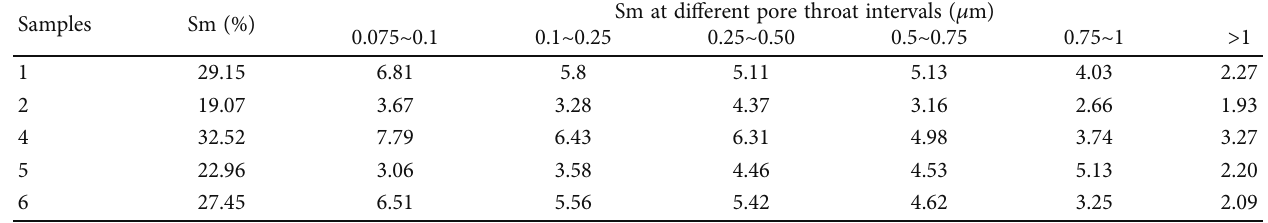
Figure 8: The variation of water saturation of samples under di ff erent centrifugal forces. Table 3: Movable fl uid saturation controlled by di ff erent pore throat intervals.